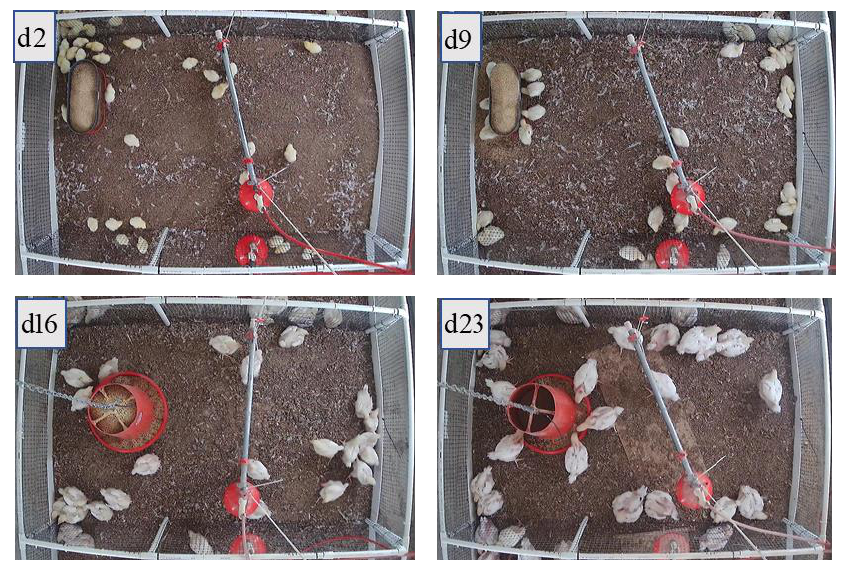
Figure 1. Examples of experimental data collection.